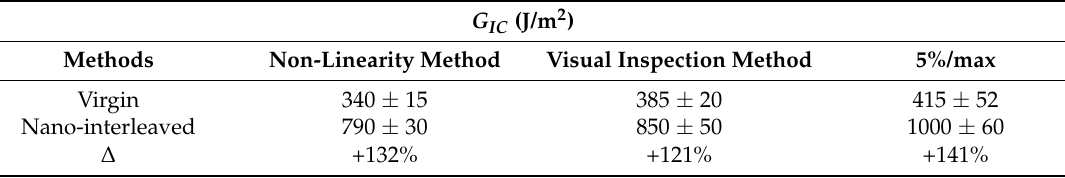
Figure 4. Trend of the critical energy release rate ( G I max ) required for the crack initiation under different numbers of cycles in fatigue tests based on ASTM D6115. Table 1. Fracture parameters obtained from mode I fracture tests measured based on ASTM D5528.